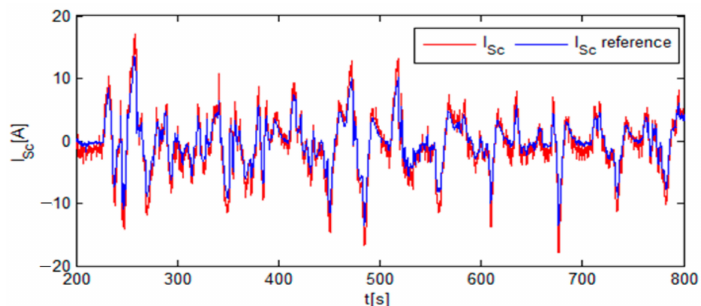
Figure 33. Zoom on the Sc current control result.